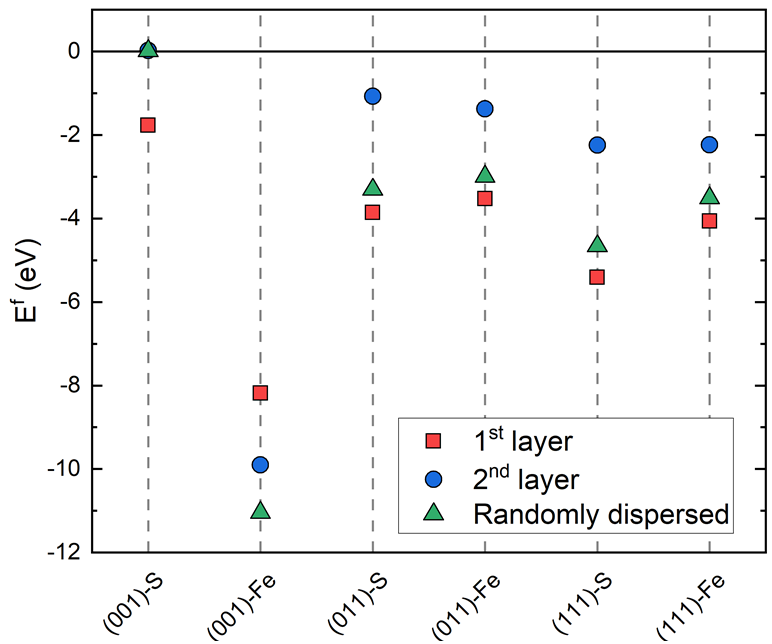
Figure 2. Calculated defect formation energies of selected Ni-doped FeS surfaces.